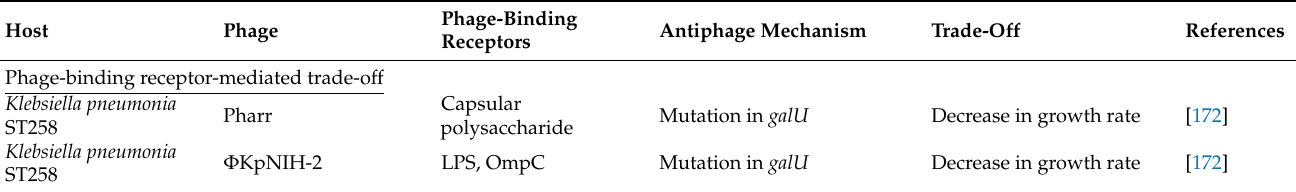
Table 1. Trade-offs between phages and